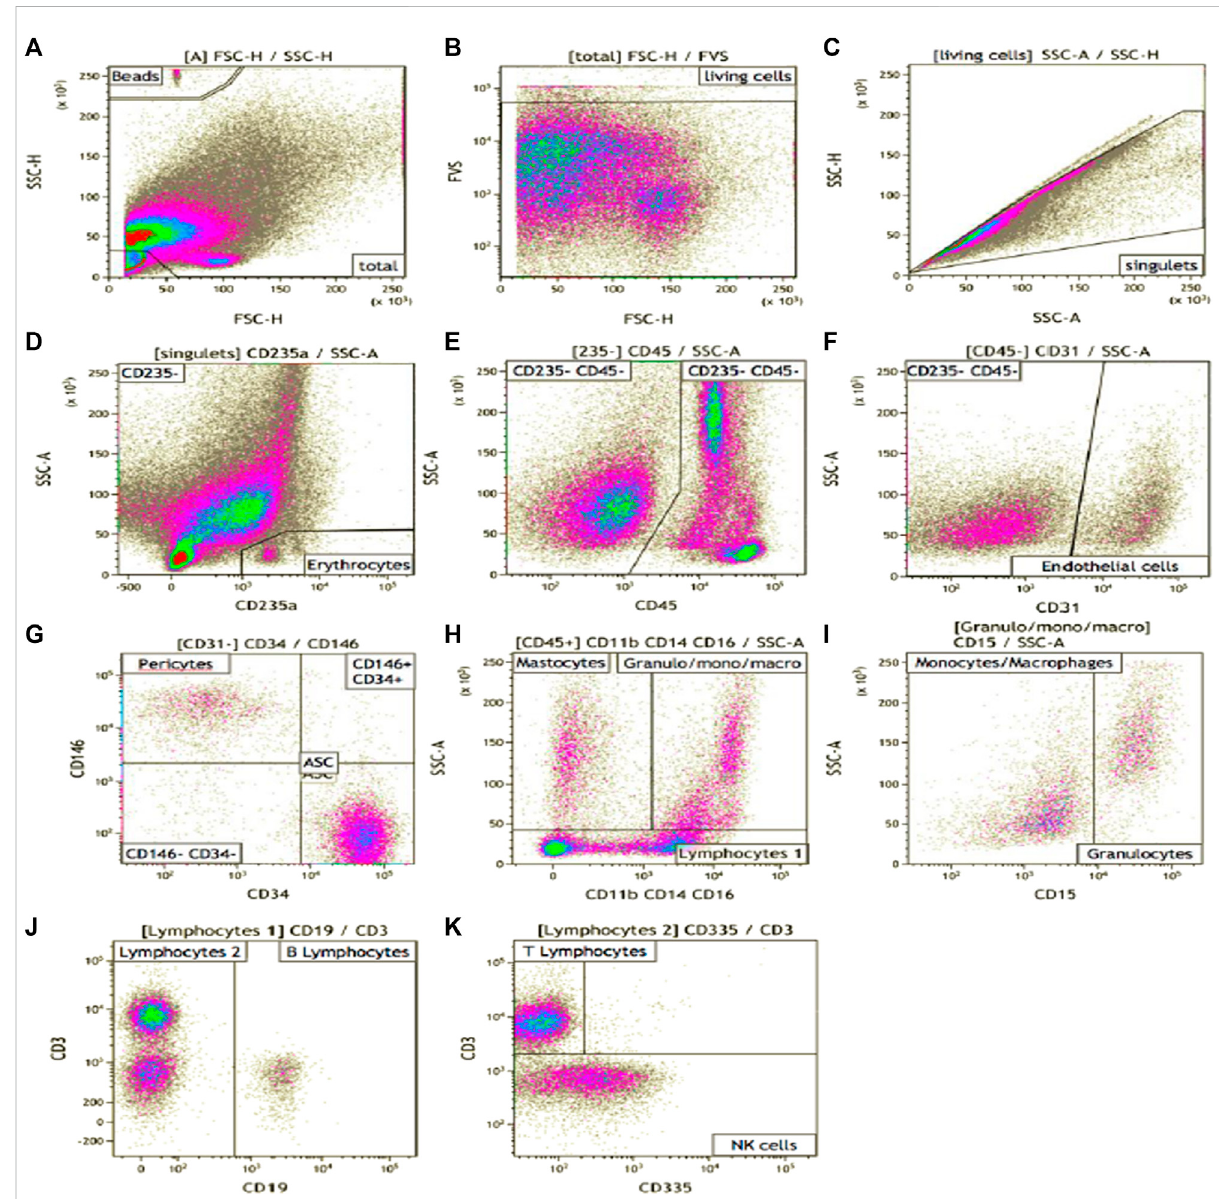
FIGURE 1 SVFphenotypegatingstrategy.ManualanalysisonKaloozasoftware. (A) showedthegatingofbeadscount.FVS-780wastheviabilitymarker (B) . (C) eliminate the doublets. CD235a stained erythrocytes (D) . CD45 was expressed by hematopoietic cells (E) . CD31 was expressed by endothelial cells (F) . CD146 stained pericytes (on CD45 − CD31 − cells) (G) . CD34 stained AUCs after an adapted gating strategy (G) . CD11b, CD14, and CD16